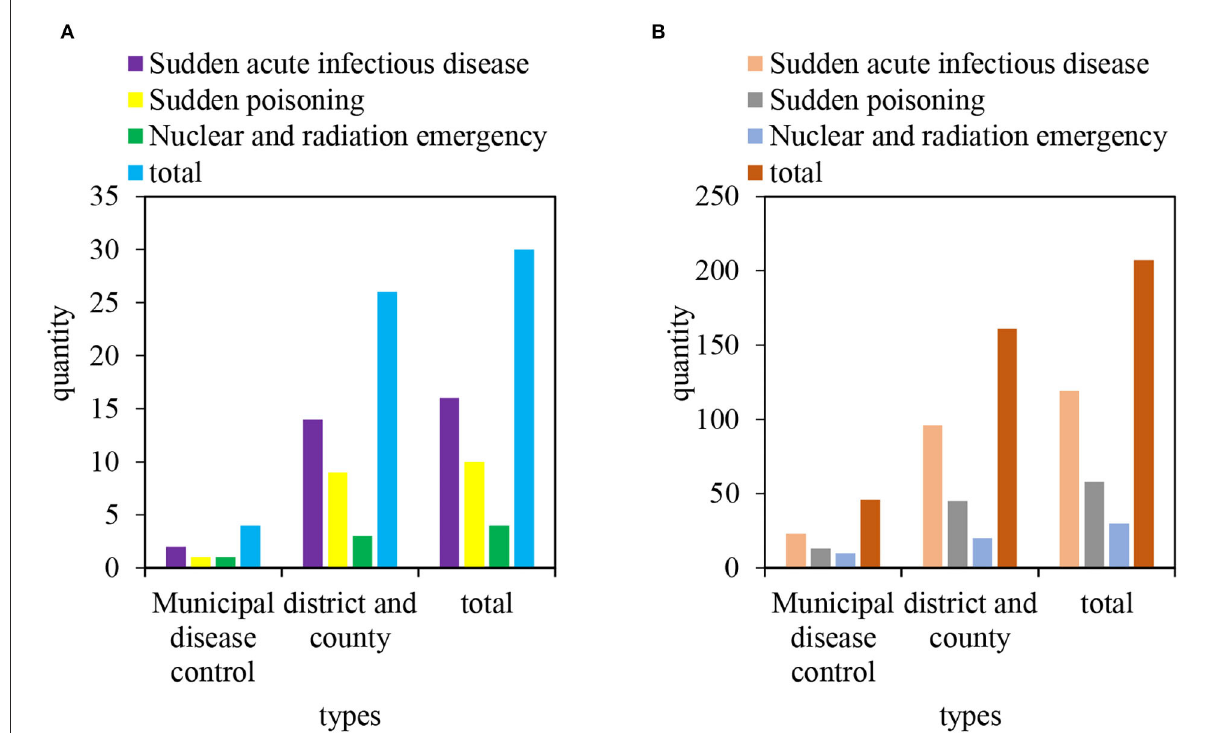
FIGURE4 Establishment of health emergency response team of disease control institutions in M City. (A) Number of teams. (B) Number of personnel.